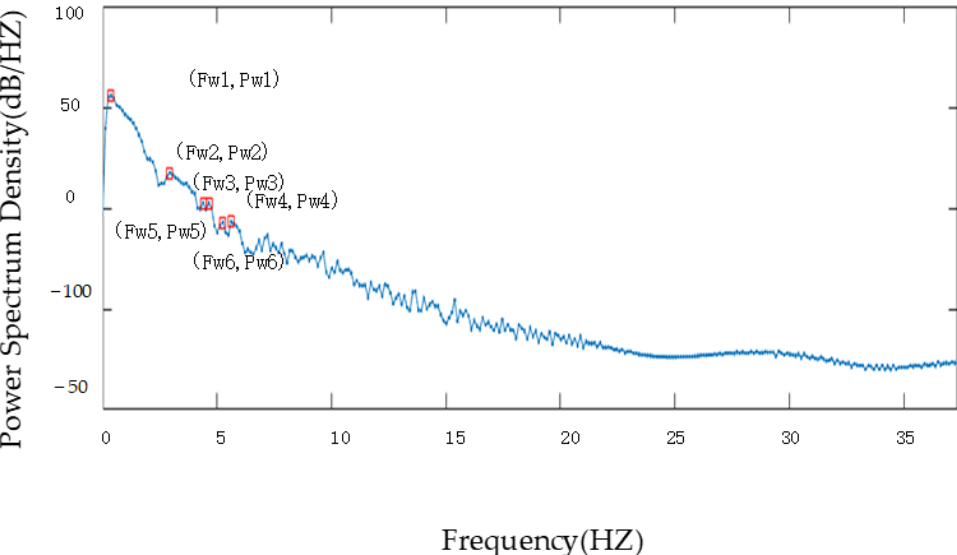
Figure 10. Welch spectral estimation of the denoised signal (Figure 7b).